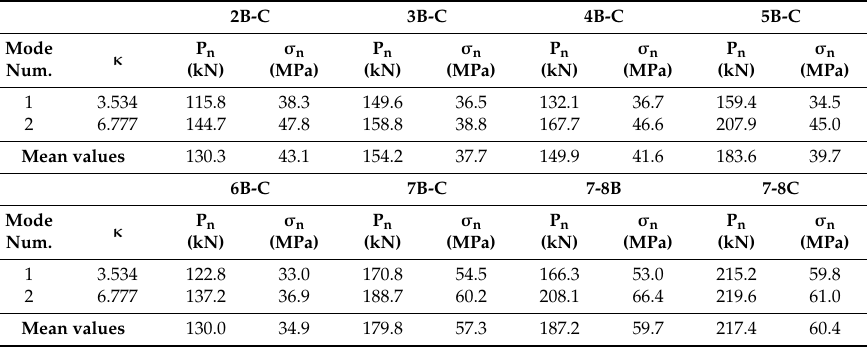
Table 6. The value of forces P n (kN) and stress levels σ n (MPa) for the observed mode shapes in the tie rods observed in the Cathedral of St. James in Šibenik at level R4. Mode